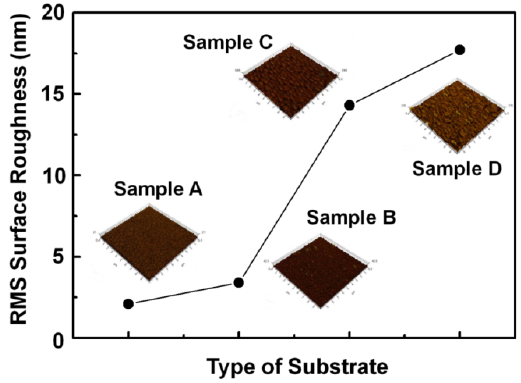
Figure 4. Atomic force microscopy (AFM) observations of GaN films grown on different substrates. RMS: root ‐ mean ‐ square.